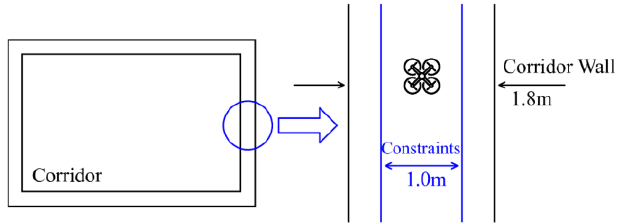
Figure 4. Simplified diagram of indoor corridor environment and its constraints.